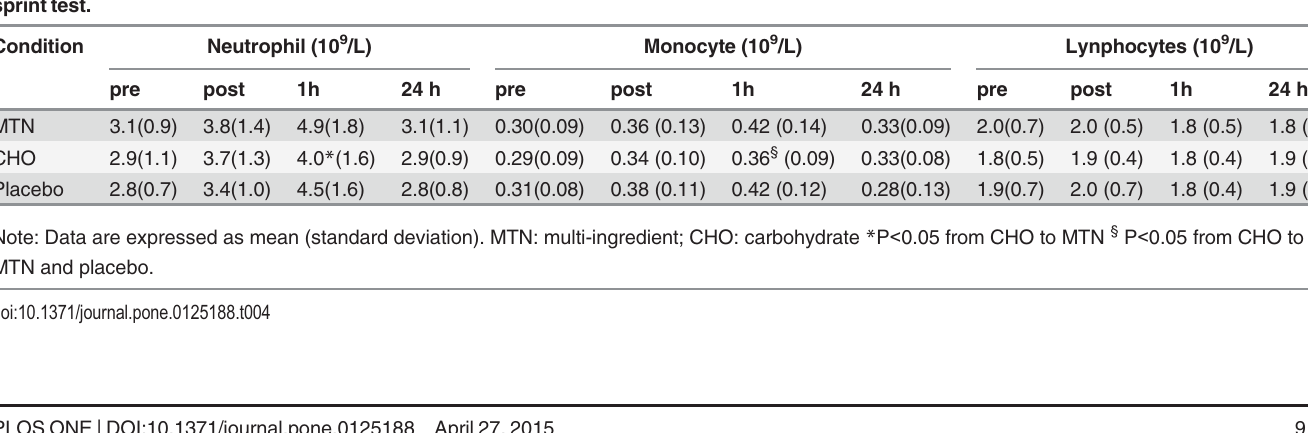
Table 4 shows the values determined for Neutrophil, Lymphocytes and Monocytes at the 4 different time points (pre, post, 1h, and 24h) for the 3 conditions. Before performing the IRS, no significant differences between treatment conditions were observed for the 3 analyzed markers: Neutrophil = 1.08, P = 0.366), Lymphocyte (F = 2.44, P = 0.123) and Monocytes (F = 0.29, (F 2,14 2,14 2,14 P = 0.754). Neutrophil counts showed a significant interaction effect between treatment conditions and = 2.77, P = 0.016, η 2 = 0.01), but no significant main effect between treatment condi- time (F 6,90 = 3.85, P = 0.051, η 2 = 0.01). However, significant differences for time effects tions (F = 2,30 = 25.64, P < 0.001, η 2 = 0.21). Post hoc analysis re- (pre, post, 1h, and 24h) were observed (F 3,45 vealed higher Neutrophil counts immediately after (post) compared to pre for CHO